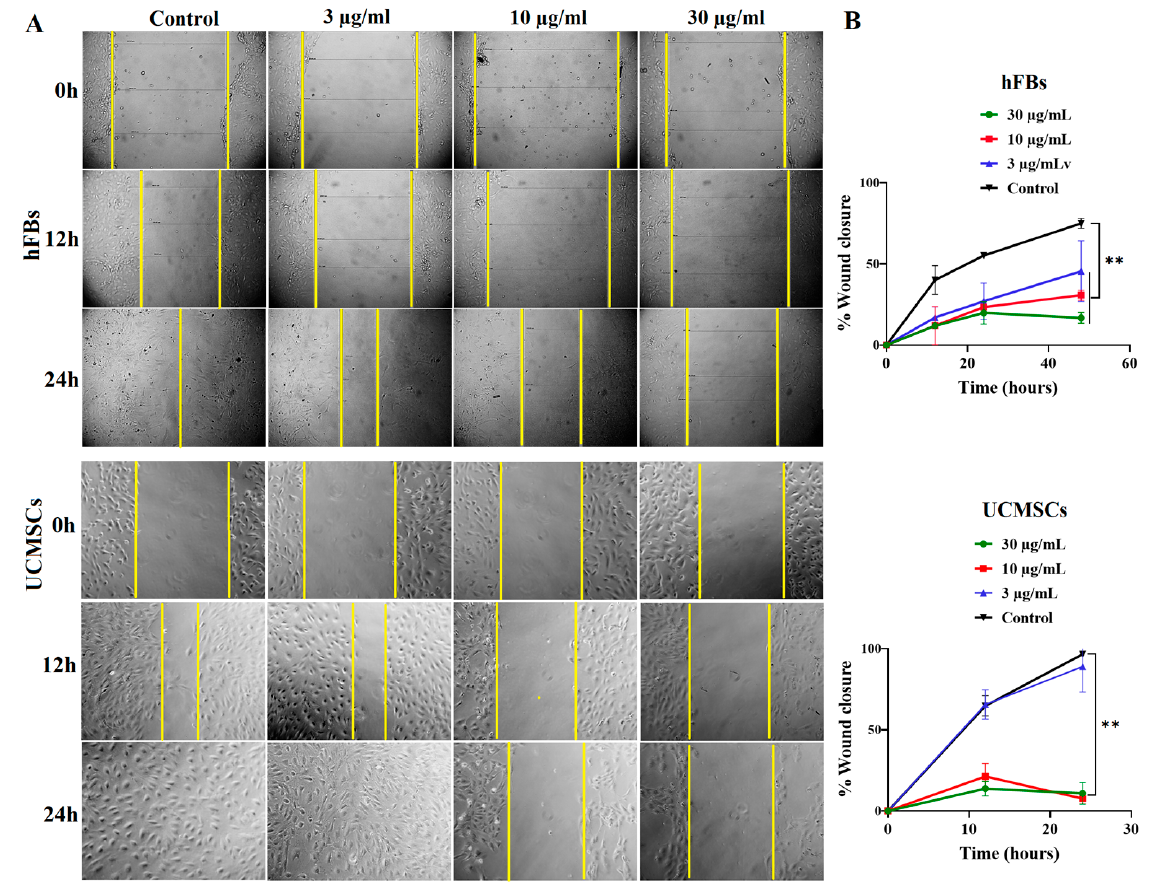
Figure 6. The effect of curcumin PM on the migration of UCMSCs and hFBs. ( A ) The images show wound closure (%) following a time of incubation with curcumin PM at two doses of 10 and 10 µg/mL. ( B ) The quantitative percentage of the wound covered after treatment with curcumin PM in UCMSCs and hFBs. The data are presented as mean ± SD, N = 3. ** p < 0.01.